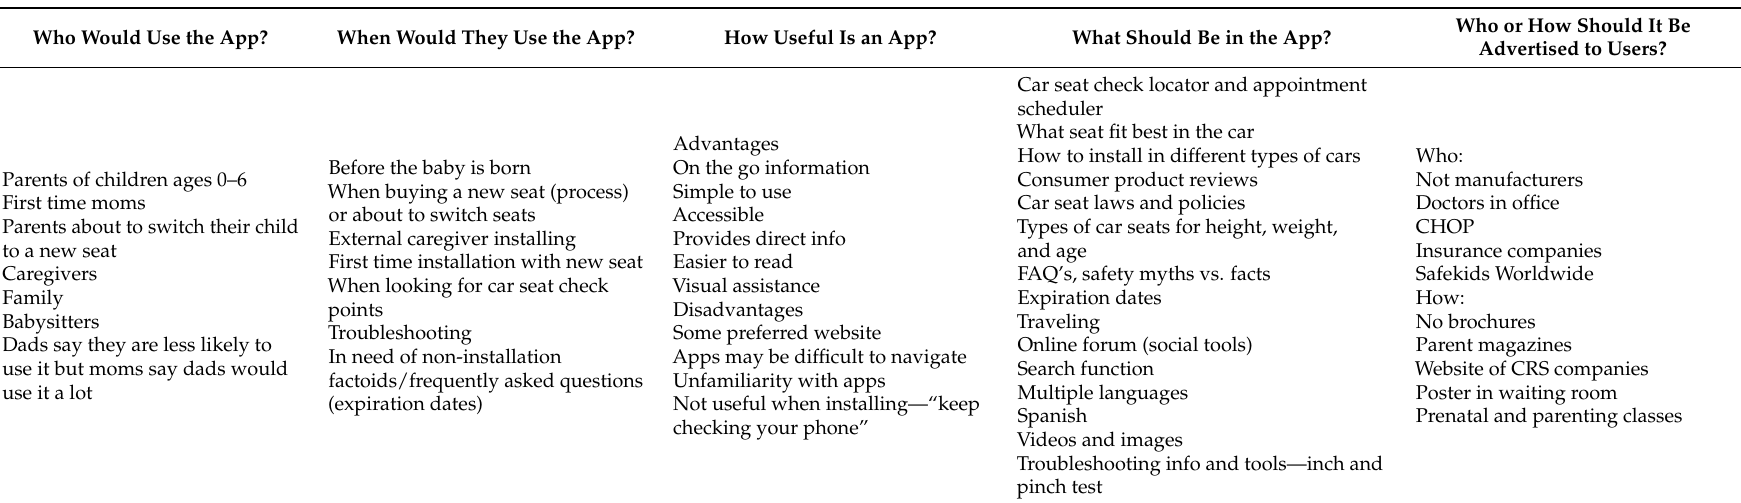
Table 2. Caregiver preferences for features/content in mobile